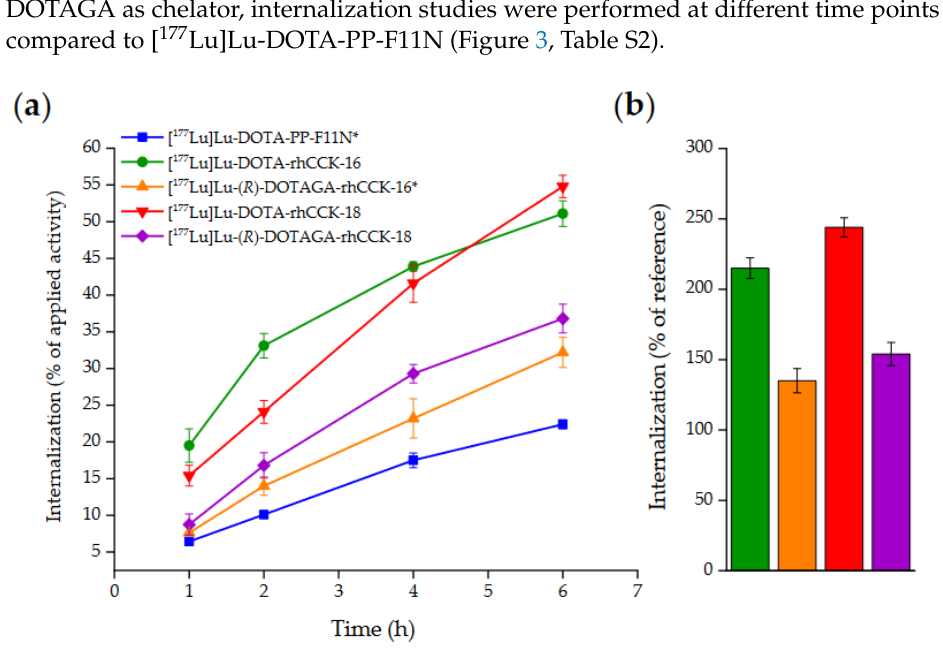
Figure 3. ( a ) CCK-2R-mediated internalization (0.25 pmol/well) measured on AR42J cells as percent (%) of applied activity (incubation at 37°C for 1, 2, 4 and 6 h, RPMI 1640, 5 mm L-Gln, 5 mL non-essential amino acids (100×), 10% FCS + 5% BSA ( v / v ), 3.0 × 10 5 cells/mL/well). ( b ) CCK-2R-mediated internalization of [ 177 Lu]Lu-DOTA-rhCCK-16 (green), [ 177 Lu]Lu-( R )-DOTAGA-rhCCK-16 (orange), [ 177 Lu]Lu-DOTA-rhCCK-18 (red) and [ 177 Lu]Lu-DOTA-rhCCK-16 (violet) after incubation at 37 °C for 6 h as percent of reference (% of [ 177 Lu]Lu-DOTA-PP-F11N). * data taken from Holzleitner et al. [19]. These data have been determined in our lab under identical conditions.